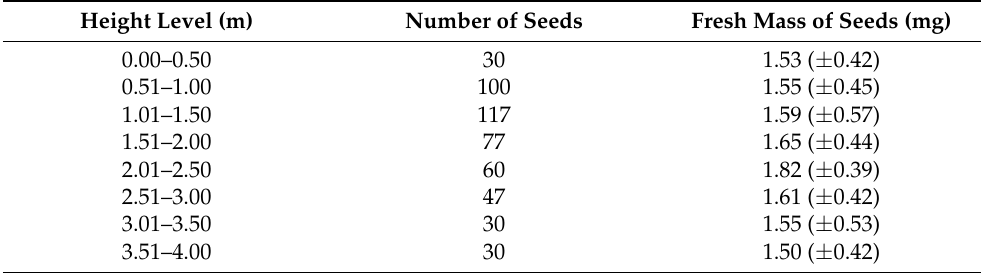
Table 4. The fresh weight of the seeds (mean ± SD) of Echinocystis lobata sampled at different height levels in selected study sites.